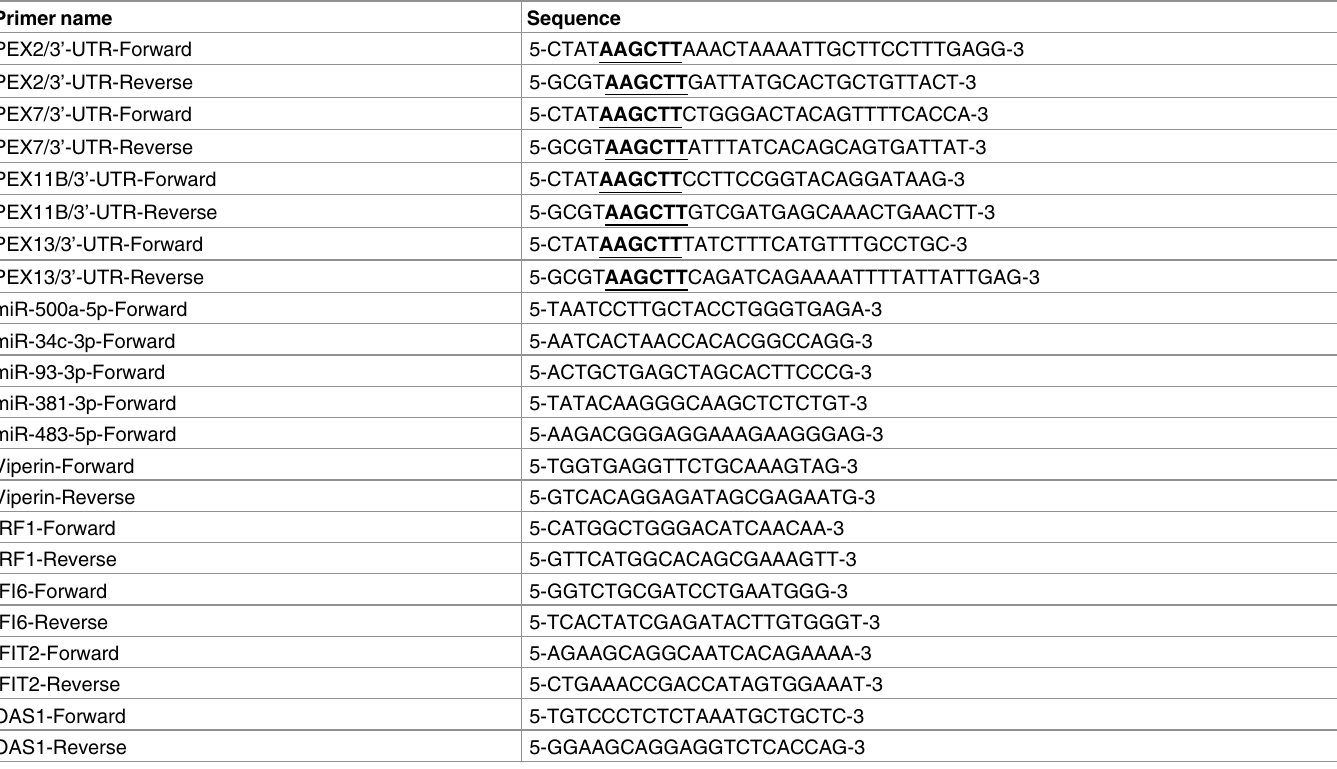
Table 2. Oligonucleotide